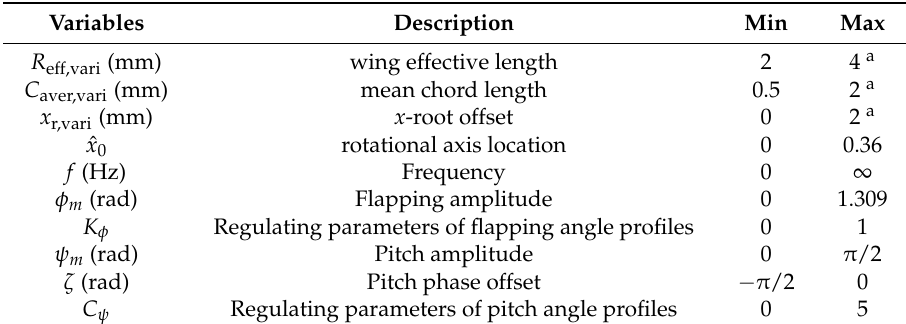
Table 1. Independent variable wing geometry parameters (WGP) and wing kinematics parameters (WKP) and their constraints.